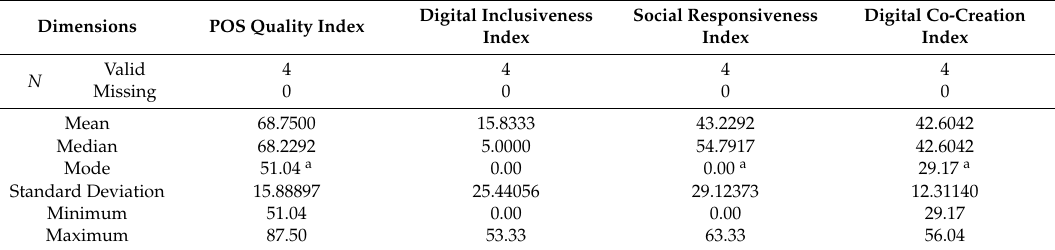
Table 1. Statistical analysis of four Living Labs according to public open spaces (POS) Quality Index, Digital Inclusiveness Index, Social Responsiveness Index and Co-Creation Index in total.